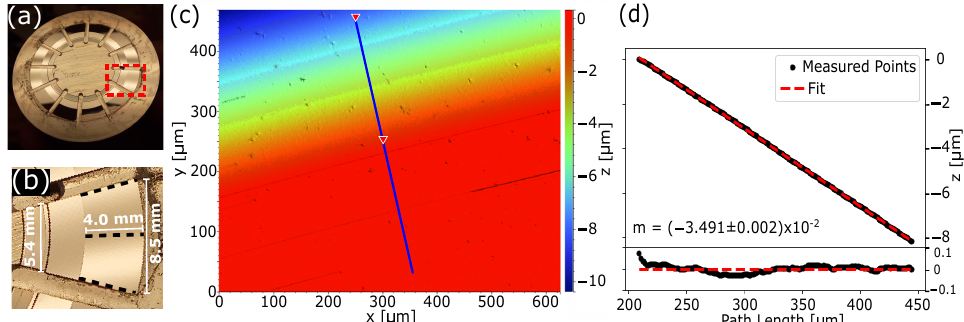
Figure 1. ( a ) Micro-prisms before assembly into the TARP. Here, the angled faces of each prism can be seen tapering radially, and each prism has been segmented into equal pieces. These pieces are then assembled with the non-angled section at the base of each prism. A single prism element, expanded in ( d ), is shown within a red box. ( b ) Enlarged image of a single prism segment whose angled surfaces, indicated with black dashed lines, are machined to 2 ◦ . Labels indicate prism base width, peak width, and prism height. Note that these width dimensions are the cord length of segmented rings which form the base and apex of the prism. ( c ) White light interferometry data showing the machined surface of the prism segment. Density plot colour shows surface height, where the flat base of the prisms is shown in red and the sloped face can be seen with varying colours. Surface imperfections can be observed which correspond to a surface finish of 20 nm roughness average (Ra). Points along the blue line were sampled to measure the angle of this surface. ( d ) These points show an angle of 1.999 ◦ ± 0.001 ◦ . This angle matches the designed surface angle of 2 ◦ . The residual plot shown below indicates that within this region, the surface form is straight to within ±